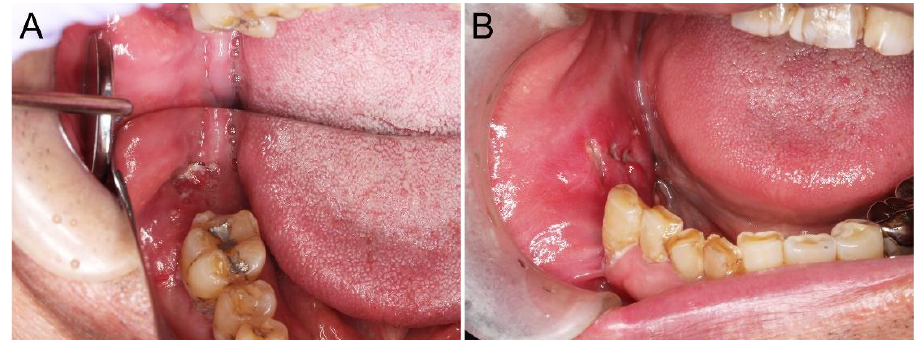
Figure 1. Intraoral findings of adenosquamous carcinoma (ASC) with the acantholytic feature. At initial onset ( A ) and recurrence ( B ). After extracting the second molar of the right side of the man- dible, an ulcerative lesion remained, and a large mass expanded to the buccal side of the first molar ( A ). At a recurrence, a submucosal mass with an ulcer was located in the right buccal mucosa ( B ).